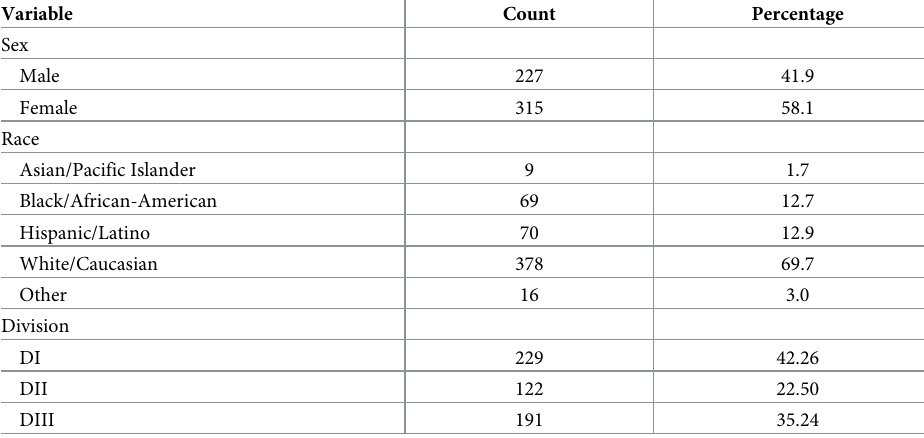
Table 1. Demographic information about participants ( n =